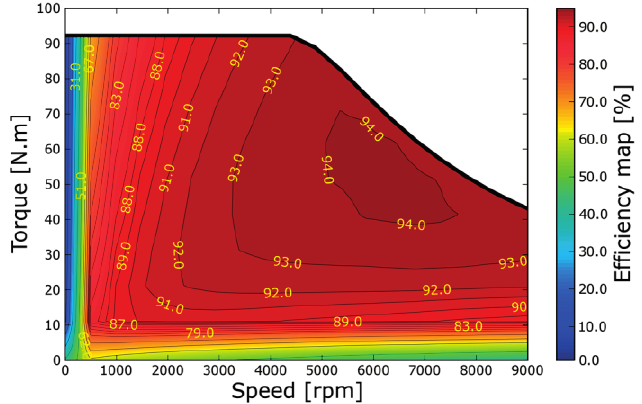
Figure 1. An example of electric engine characteristic